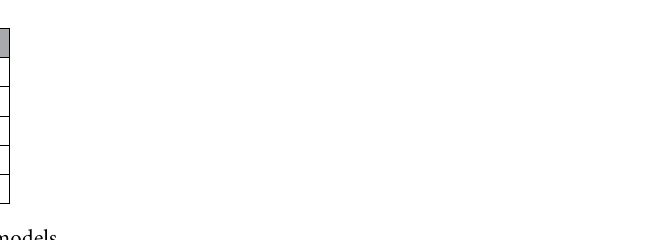
Table 2. The performance of various